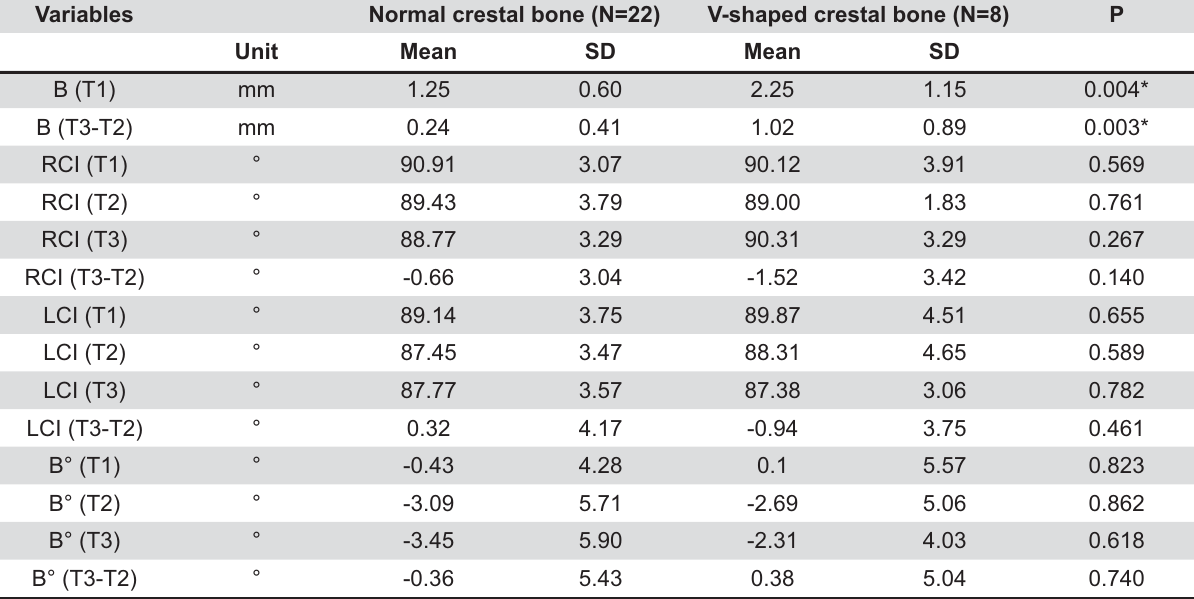
Table 3- Independent t test to compare difference between subjects with normal intermaxillary crestal bone and with v-shaped crestal bone